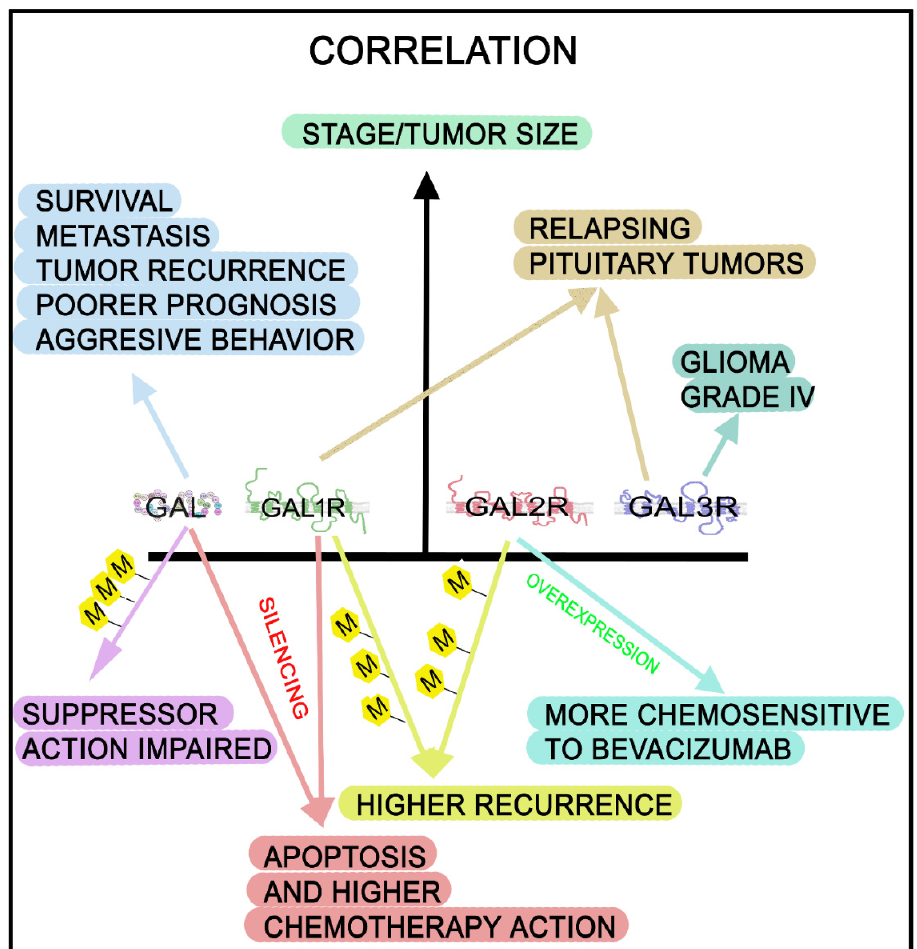
Figure 5. The galaninergic system has been correlated with survival, metastasis, tumor recurrence and poorer prognosis. M: methylation; M,M,M: hypermethylation.